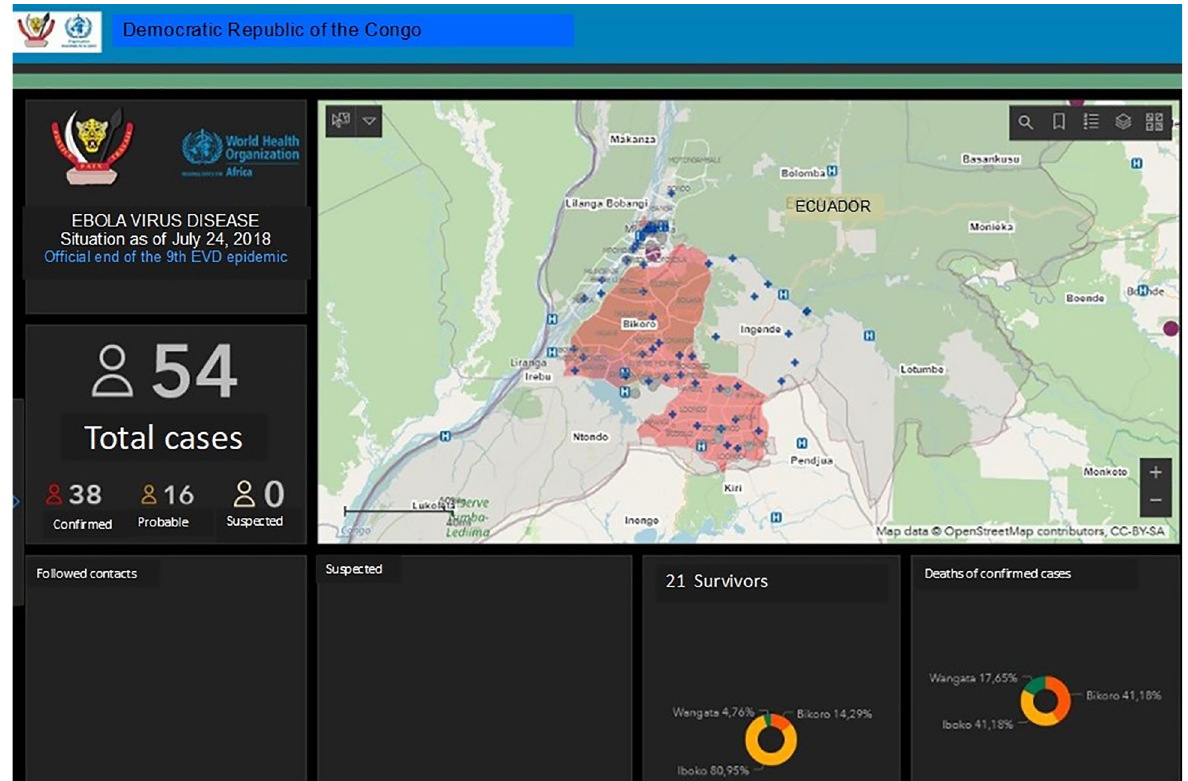
Fig. 3. WHO Dashboard for the 2018 epidemic in Bikoro (DRC). Source: data portal and mapping, Ebola outbreak response. https://ebolaoutbreak2018-who.opendata.arcgis.com/ (Creative Commons Attribution-NonCommercial-ShareAlike 3.0). DRC – Democratic Republic of the Congo; WHO – World Health